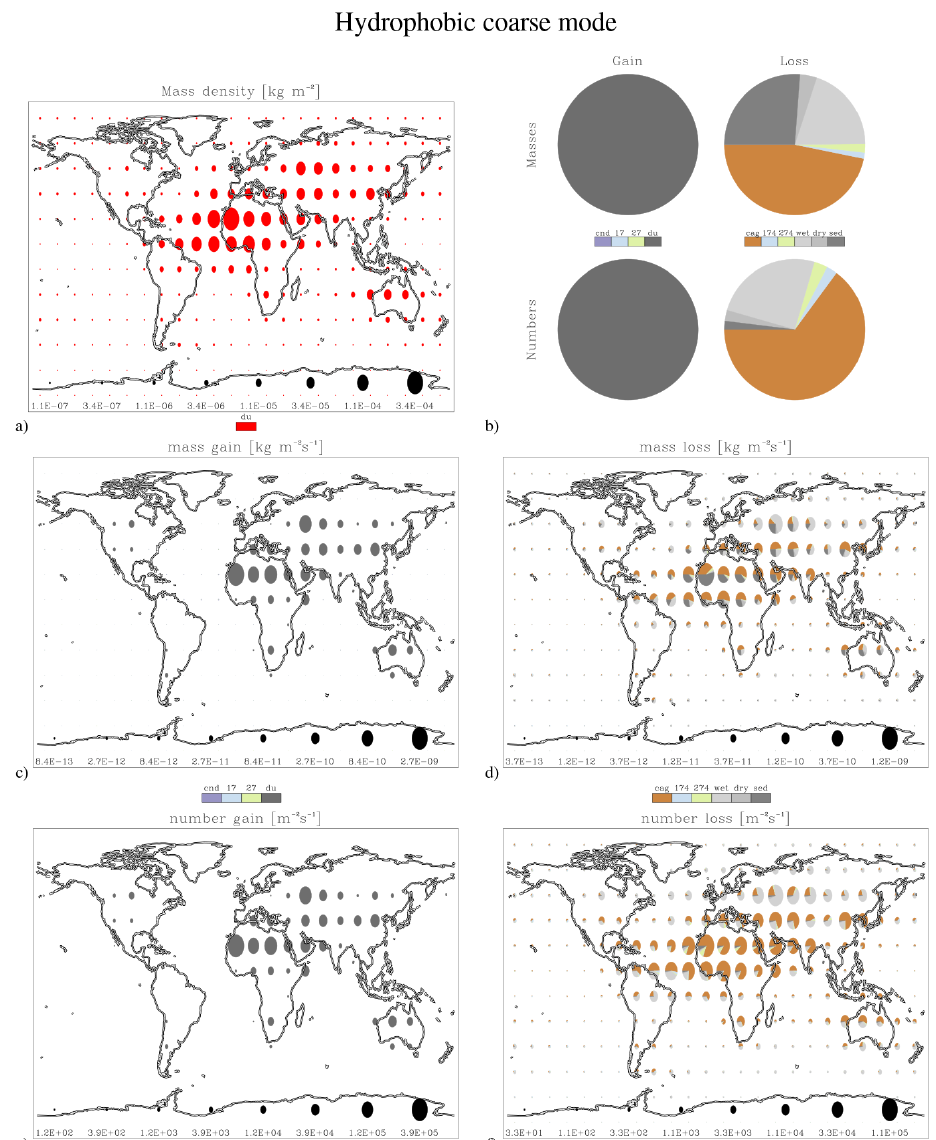
Figure 20. Global distribution of annual burdens (a) and tendencies ( b, c, d, e and f ) of the hydrophobic coarse mode. The colors indicate either species (defined in Table 3) or processes (defined in Table 2). The pie chart shows fractional contributions, while the radius of the pie indicates total column burden or total column tendency (logarithmic scale as shown in black at the bottom of panels a, c, d, e and f ). Panel b shows a global average of the